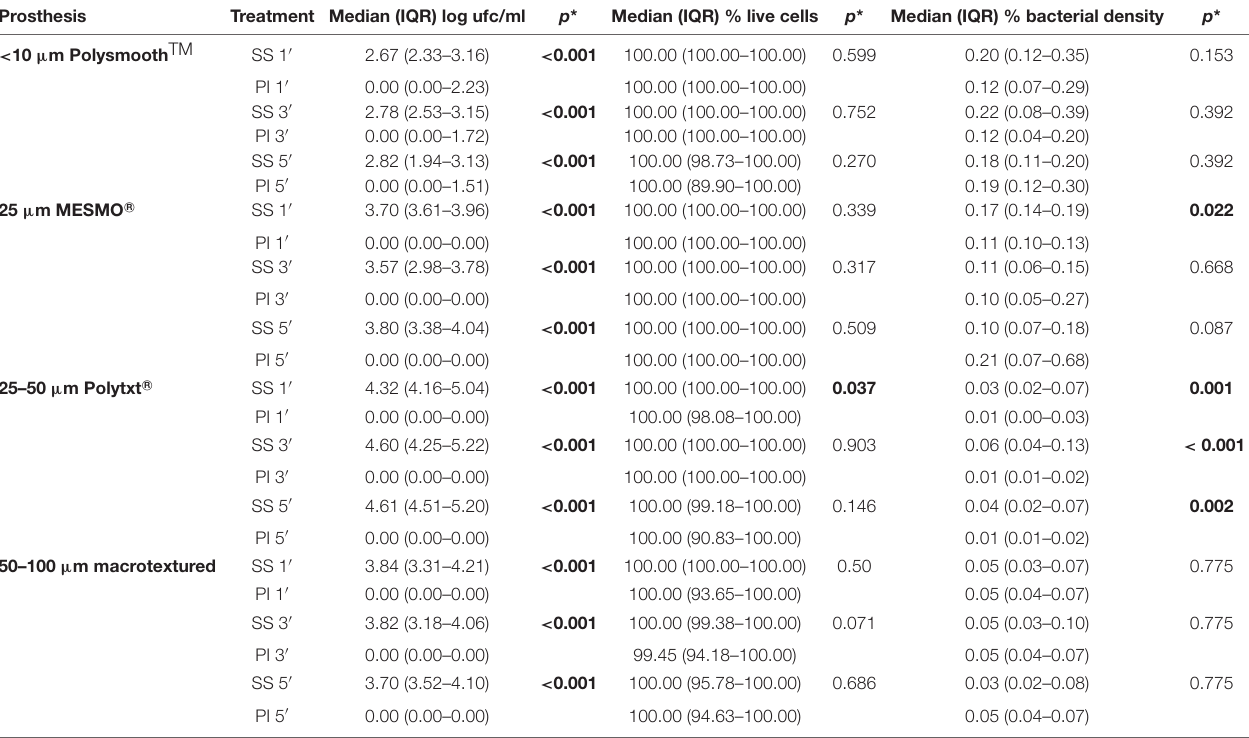
TABLE 3 | Results for povidone iodine at three times of exposure in Polytech R (cid:13) implants. Prosthesis Treatment Median (IQR) log ufc/ml p * Median (IQR) % live cells Median (IQR) % bacterial